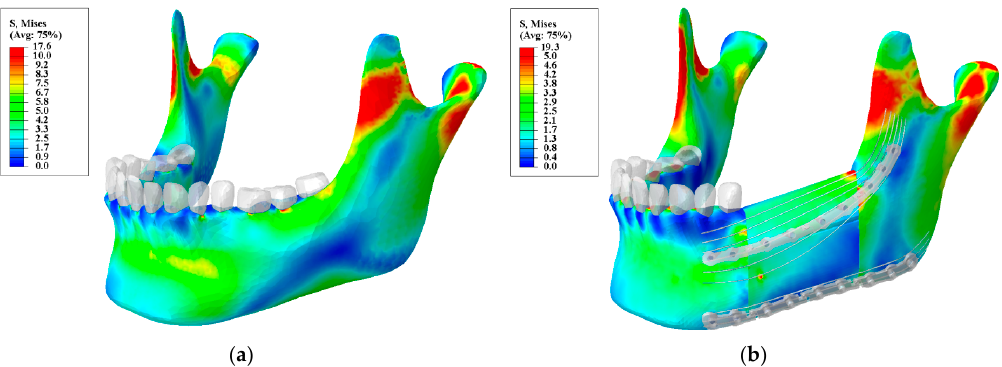
Figure 13. Von Mises stress distribution for: ( a ) a normal mandible; and ( b ) a reconstructed mandible with releasable Ti-6Al-4V hardware and underlying optimized NiTi Bone Bandaid wires. (Unit: megapascal (MPa)).